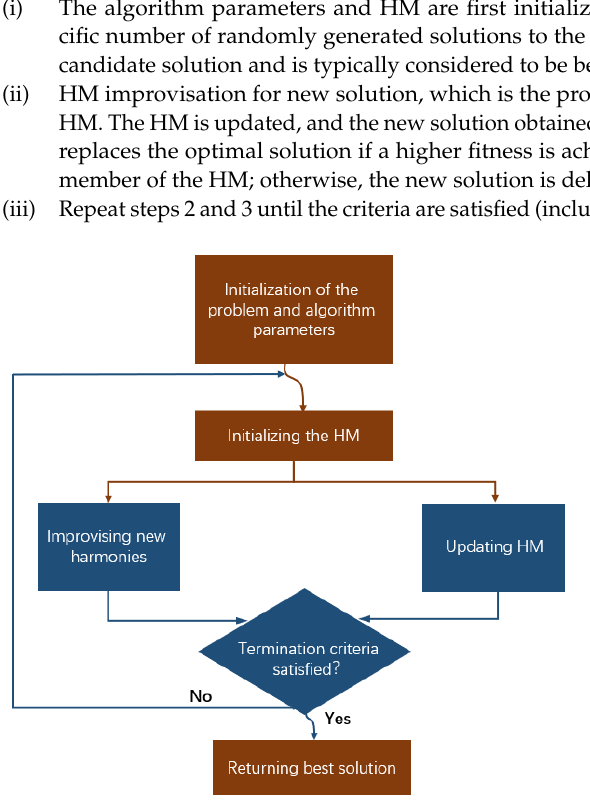
Figure 20. Steps of the HSA.